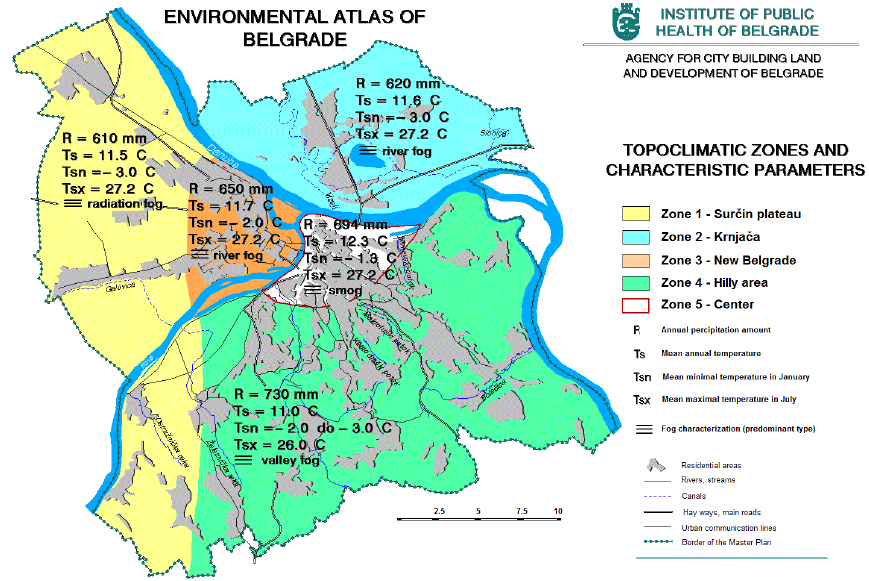
Figure 3. Topoclimatic zones of Belgrade (https://www.zdravlje.org.rs/ekoatlas/volbe/17ev.gif, accessed on 23 August 2022).